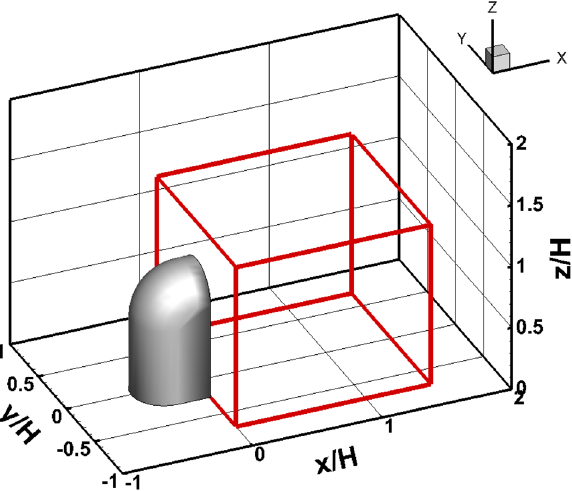
Figure 5. Training domain for ANFIS prediction (red box). The selected domain was used to observe the flow characteristics of the wake region with ranges of 0 < x/H < 1.5, − 0.7 < y/H < 0.7, and 0 < z/H <